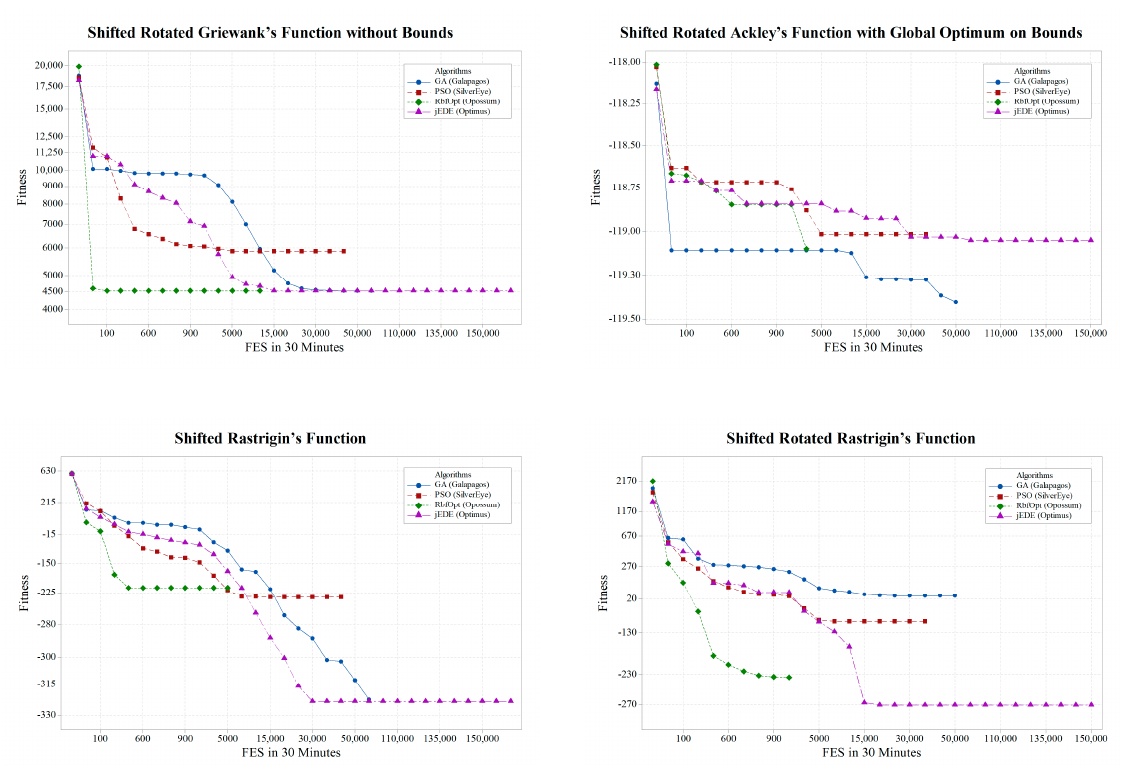
Figure 9. Convergence graphs of CEC2005 benchmark functions.